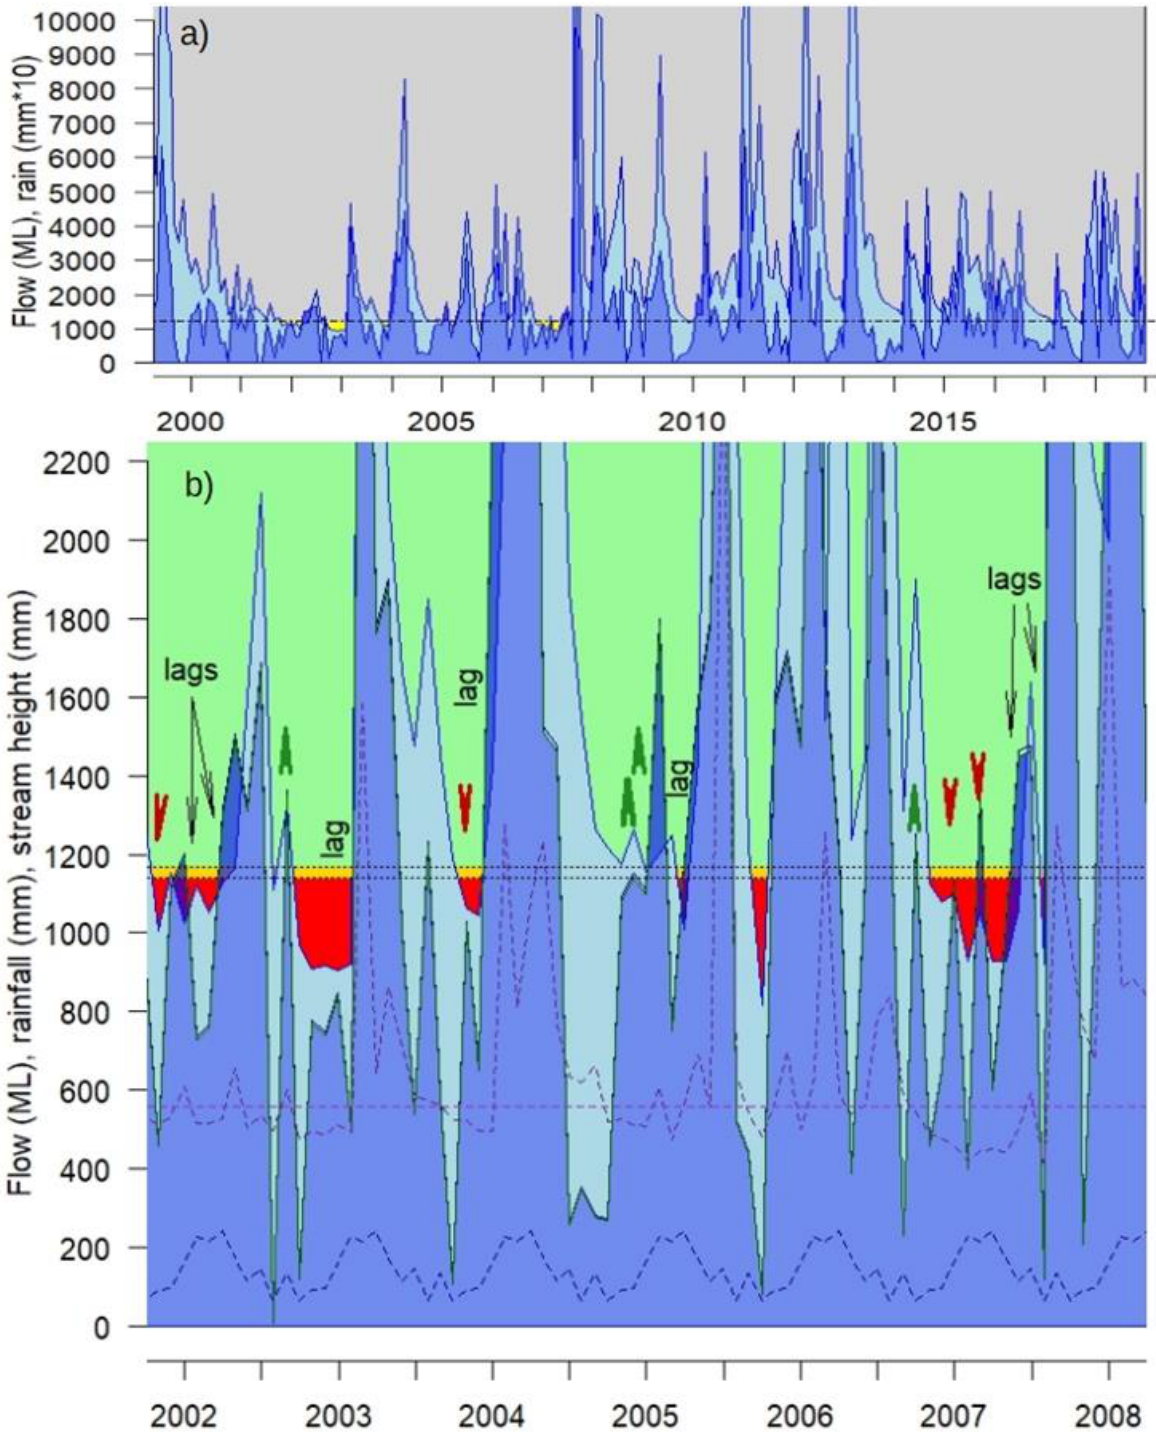
Figure 5. Baseflow estimation from the Teewah Creek stream gauge. Monthly streamflow (light blue) and rainfall (medium blue, mm × 10) for Teewah Creek: a) 1999–2019 and b) July 2001 to June 2008. Stream height is indicated by the dashed purple line; the horizontal dotted purple line represents the tenth percentile of stream heights when flow exceeds 1160 ML month -1 . The lowest dashed line represents average monthly rainfall (mm). Recharge deficits are presented (yellow) as occurring when rainfall is unlikely to increase streamflow. Arrows indicate changes in whether increased streamflow is expected after a rainfall event when flows are above or below apparent balance. Appreciable temporal lags between rainfall and increased streamflow are indicated, and commence during periods of